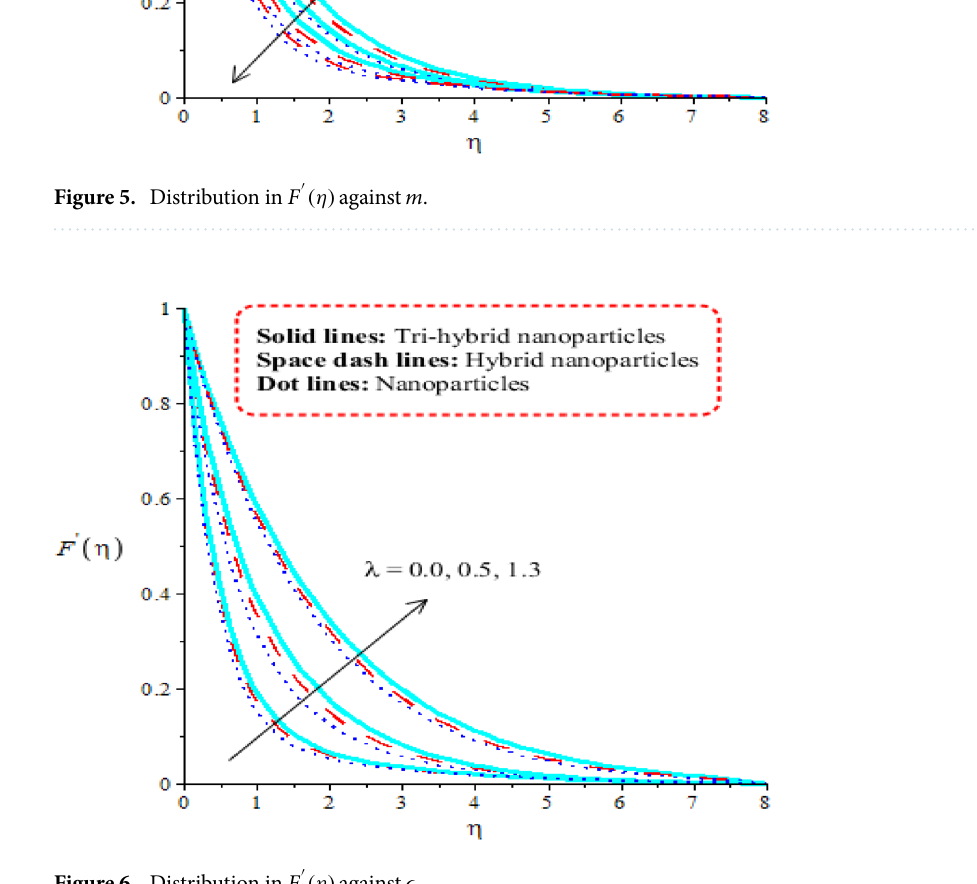
Figure 6. Distribution in F ′ (η) against ǫ